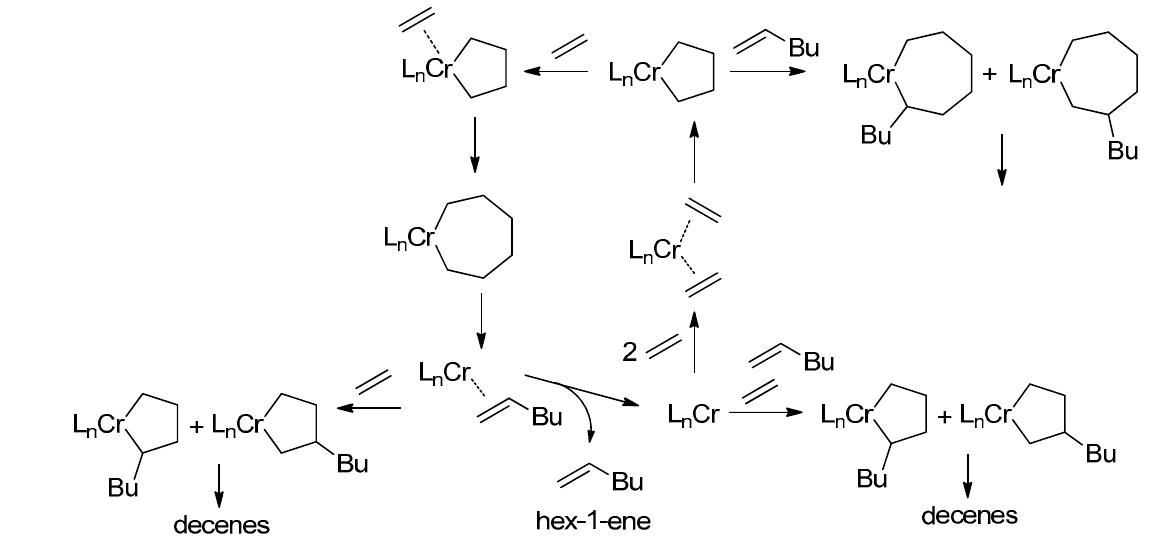
39 of 63 Figure 26. ( a ) Proposed mechanism of ethylene coordination/insertion on the supported CpV– Et 2 AlCl complex; ( b ) optimized geometry of the key transition state. Reprinted with permission from [217]. Copyright (2020) Elsevier B.V. 5. Complexes of Cr 5.1. Selective Oligomerization of Ethylene Catalyzed by Cr Complexes The selective oligomerization of ethylene with the use of Cr catalysts, resulting in the formation of hex-1-ene and oct-1-ene, is becoming an important contemporary